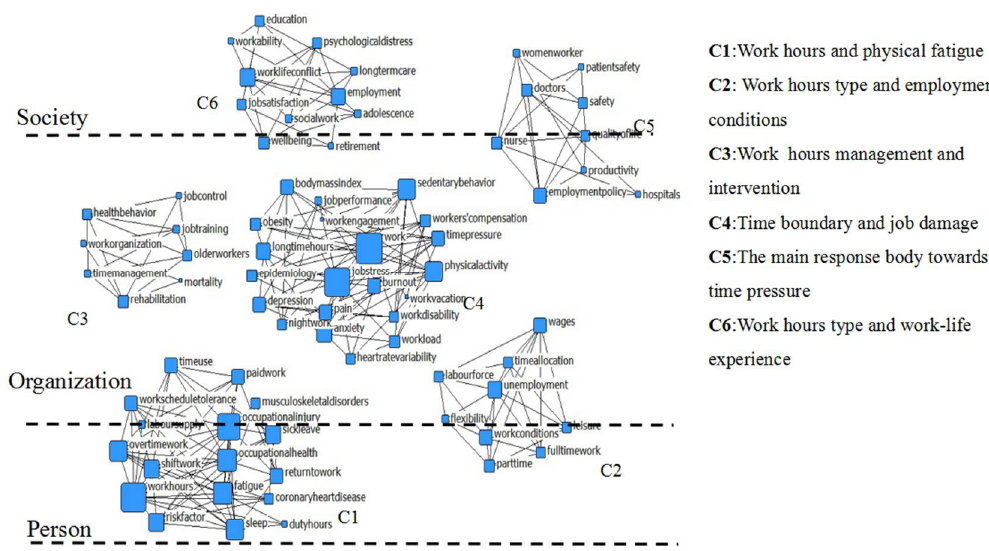
Figure 4. The hierarchical structure of cluster analysis.